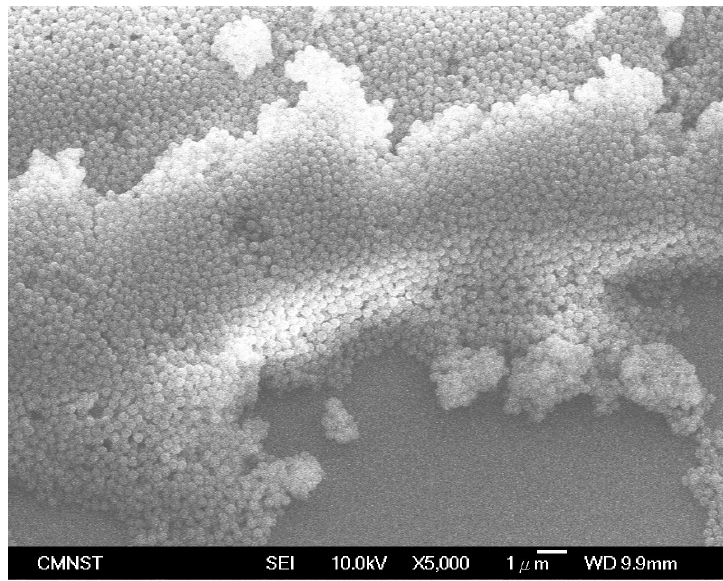
Figure 3. Three-dimensional structure produced by silica nanoparticles observed by SEM.